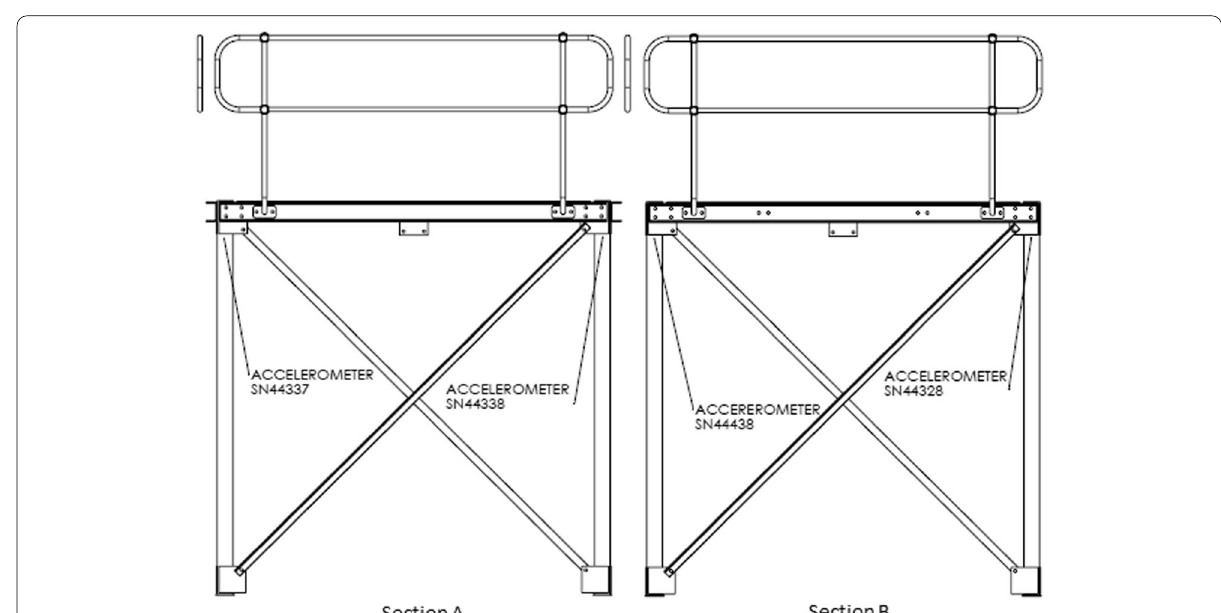
Fig. 4 Accelerometer mounted on the frame – lateral movements